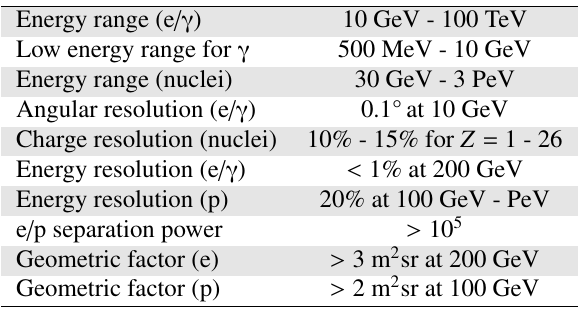
Table 1. Main requirements for the HERD